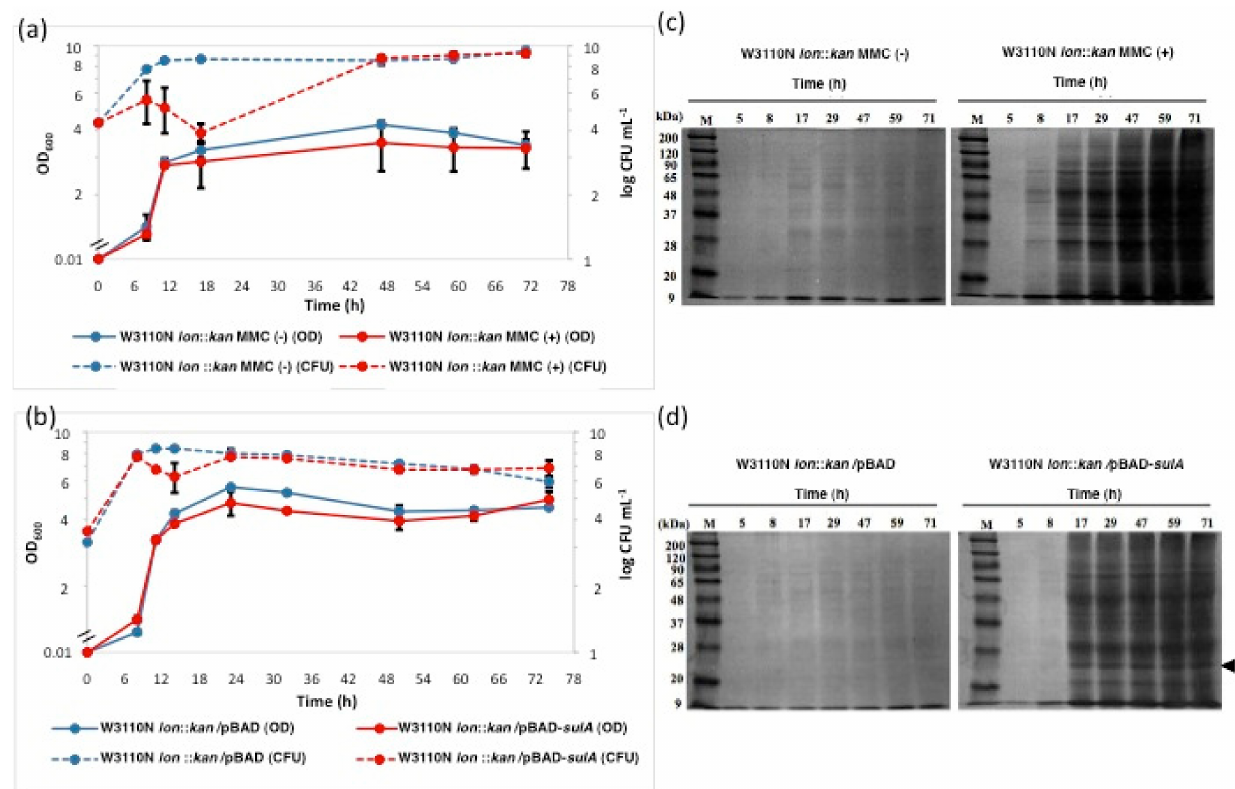
Figure 1. Effects of mitomycin C and overexpression of sulA on cell growth and cell lysis. W3110N lon :: kan cells were grown in LB medium containing kanamycin ( a ) and W3110N lon :: kan cells harboring pBAD24 or pBAD- sulA ( b ) were grown in LB medium containing ampicillin and kanamycin, and mitomycin C (MMC) and L-arabinose were added at 5 h (OD 600 of about 0.5) at the final concentrations of 0.1 µ g/mL and 0.1%, respectively. Cell turbidity (straight lines) and colony forming units (CFU) (dotted lines) were determined. Red circles and blue circles in ( a ) represent conditions with and without MMC, respectively; red circles and blue circles in ( b ) represent W3110N lon :: kan cells harboring pBAD- sulA and W3110N lon :: kan cells harboring pBAD24, respectively. Proteins from the medium fractions of cultures of W3110N lon :: kan cells with and without MMC ( c ) and of W3110N lon :: kan cells harboring pBAD- sulA and W3110N lon :: kan cells harboring pBAD24 ( d ) were recovered and subjected to SDS-PAGE as described in the Materials and Methods Section. An arrowhead indicates the position of the size of SulA (18.8 kDa). Lane M is molecular markers. Error bars stand for ±